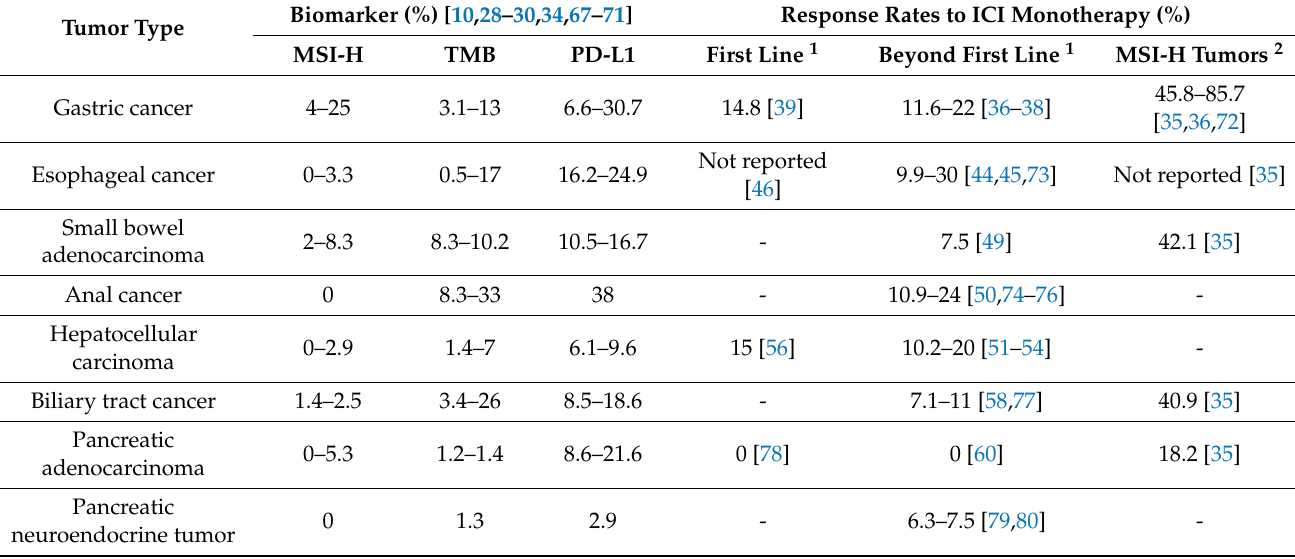
Table 3. Prevalence of MSI-H, TMB-H and PD-L1 in non-colorectal gastrointestinal cancers and response rates to immune checkpoint inhibitors